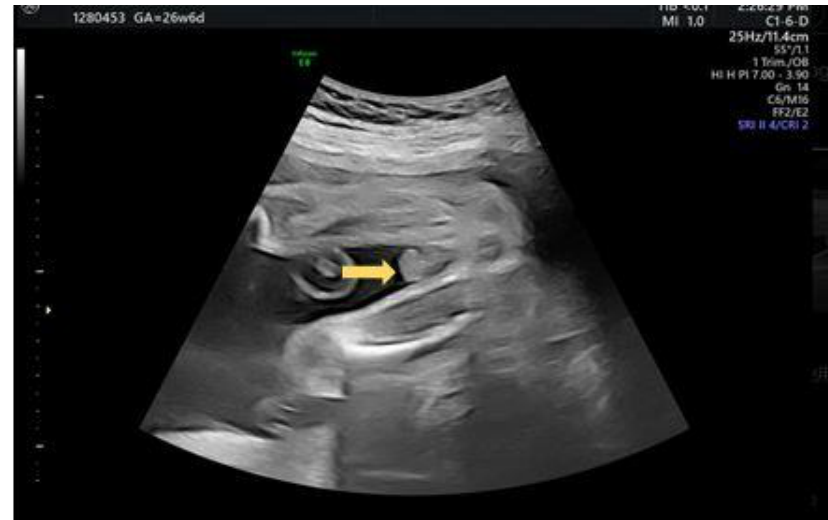
Figure 8. Split jet of urinary stream (arrows) seen after external provocation under gray scale.